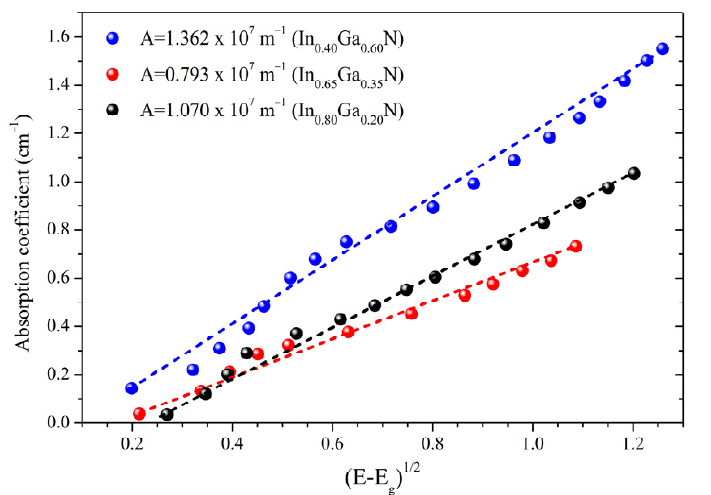
Figure 3. The absorption constant (A) for InGaN alloy with different In molar fractions calculated from the Absorption coefficient vs. (E − E g ) 1/2 plot [59]. The gradient of the graded bandgap ideal photocurrent most decays to zero to es- timate the adequate thickness necessary to achieve high efficiency. As shown in the inset of Figure 4, each incident photon generates an electron-hole pair contributing to the